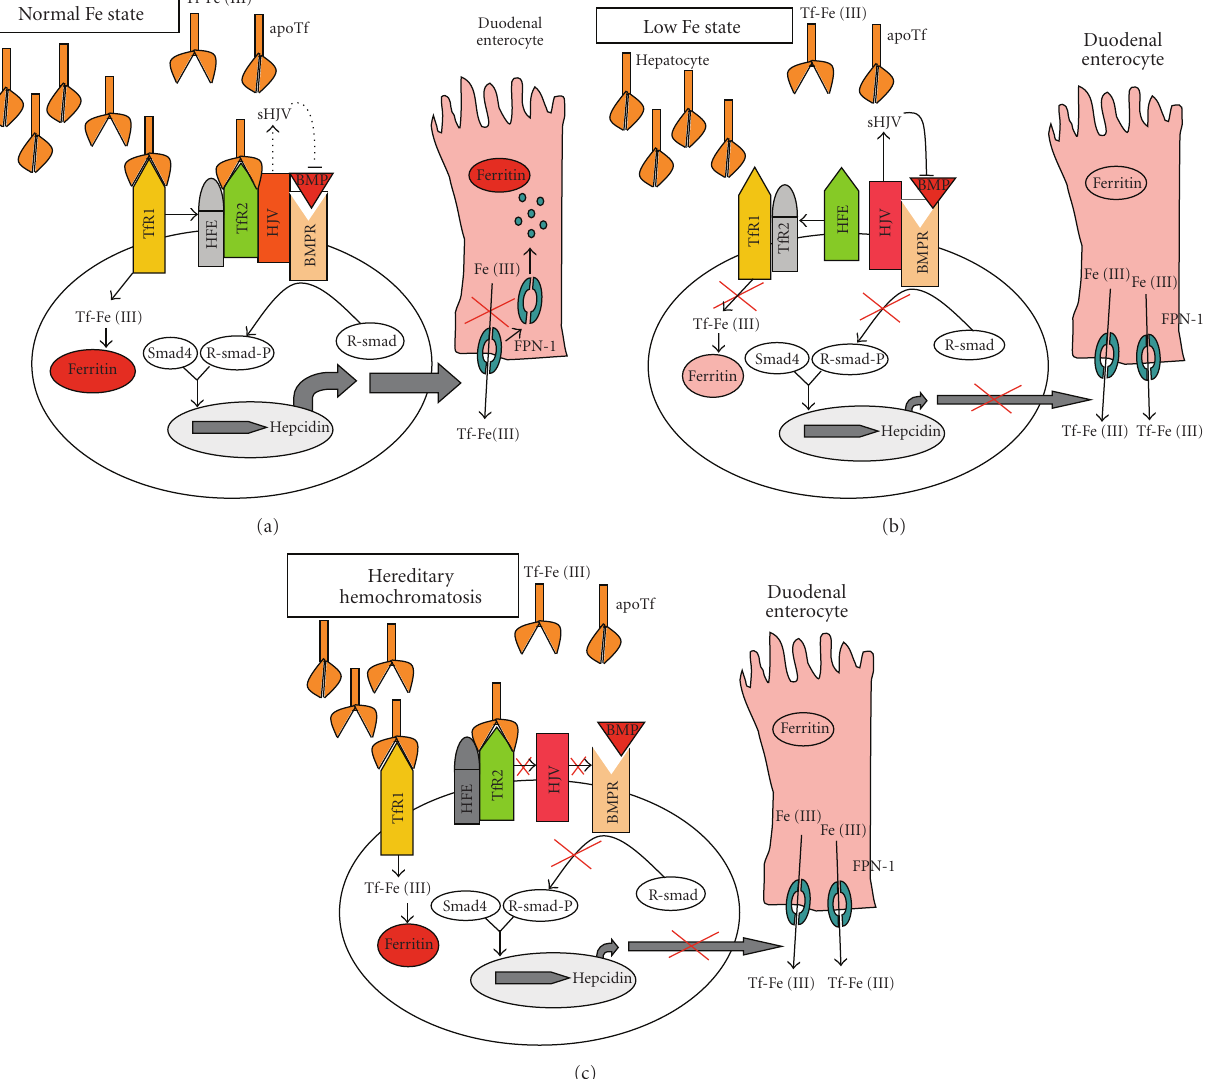
Figure 2: Hepcidin regulation through the BMP pathway, demonstrating e ff ects of a functional response to systemic iron status and the dysregulation of proteins resulting in iron